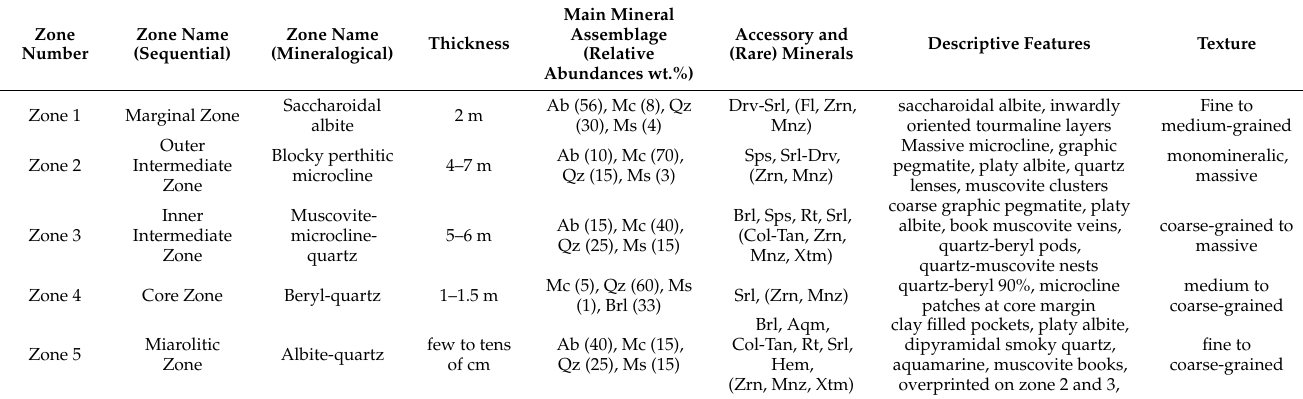
Table 1. Description of internal zonation of Yamrang Pegmatite, Ikhabu Pegmatite Field (IPF), Eastern